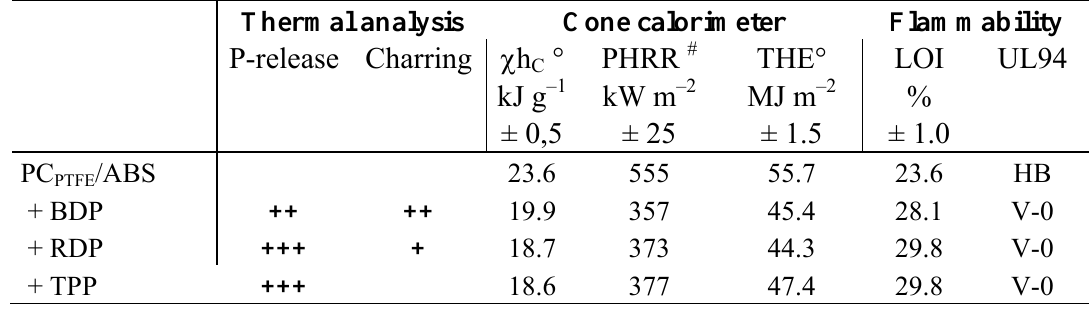
Table 7. Propensity for phosphorus release and charring determined by thermal analysis /ABS (ratio = ~5:1) materials, combustion efficiency multiplied by the effective for PC PTFE heat of combustion ( χ⋅ h ), PHRR and THE determined by cone calorimeter and C flammability (LOI, UL